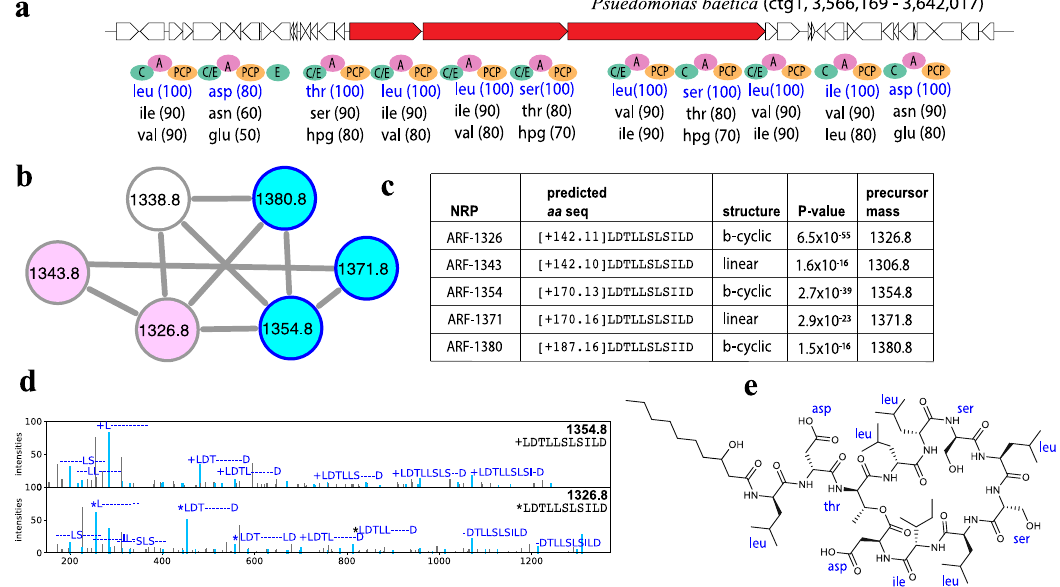
Fig. 8 Arthrofactin (ARF) NRP family. a The BGCs generating the NRP in Pseudomonas baetica sp. 04-6(1) along with the NRPS genes (shown in red) and A-, C-, C/E-, PCP-, and E-domains in these NRPSs. The rest of the genes in the corresponding contigs are shown in white. Three highest-scoring amino acids for each A-domain in these BGCs (according to NRPSpredictor2 (ref. 15 ) predictions) are shown below the corresponding A-domains. Amino acids appearing in the known NRP ARF-1354 with amino acid sequence [ + 170.13]LDTLLSLSILD are shown in blue. b Spectral network formed by the spectra that originate from NRPs in the ARF family. The known arthrofactins are shown in blue, while the purples nodes represent the previously unreported variants identi fi ed by NRPminer. All identi fi ed athrofactins share the same core NRP LDTLLSLSILD. c Sequences of the identi fi ed NRPs in this family (with the lowest p value among all spectra originating from the same NRP). Column “ structure ” shows if the predicted structure for the identi fi ed NRPs is linear or branch- cyclic (shown by b-cyclic). The p values are computed based on MCMC approach using MS-DPR 89 with 10,000 simulations. d Two annotated spectra representing the PSMs (with the lowest p values among spectra originating from the same NRPs) corresponding to ARF-1354 and 1326. The two spectra were annotated based on predicted NRPs [ + 170.13]LDTLLSLSILD (PSM p value 2.7 × 10 − 39 ) and [ + 142.11]LDTLLSLSILD (PSM p value 6.5 ´ 10 − 55 ), from top to bottom. The “ + ” and “ * ” signs represent the addition of [ + 170.13] and [ + 142.11], respectively. e The 2D structure of known arthrofactin ARF-1354 (ref. 80 ). NRPminer identi fi ed this NRP with p value 2.7 × 10 − 39